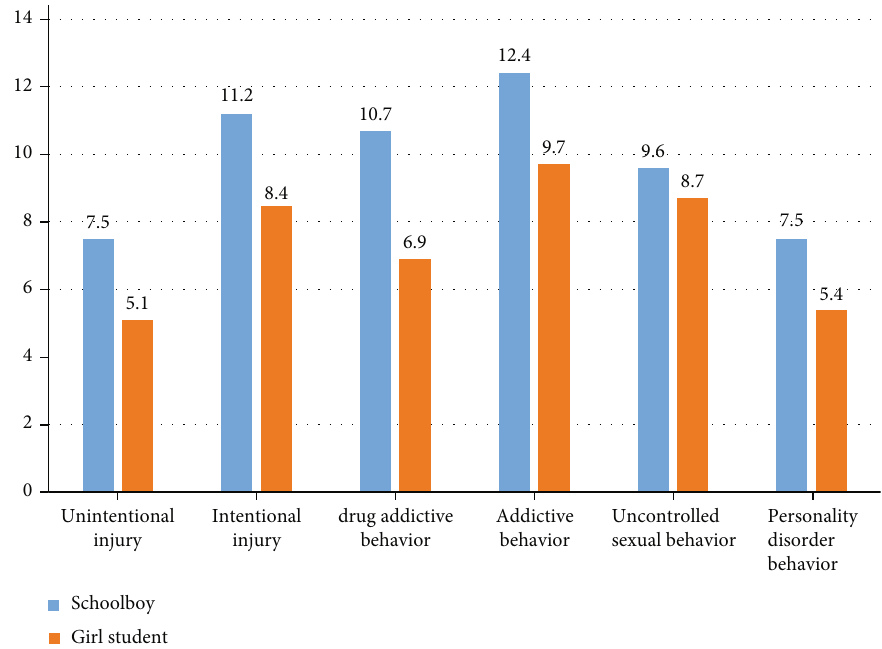
Figure 2: Visual chart of recurrence times of risk behavior intervention in adolescents of di ff erent genders in three years.